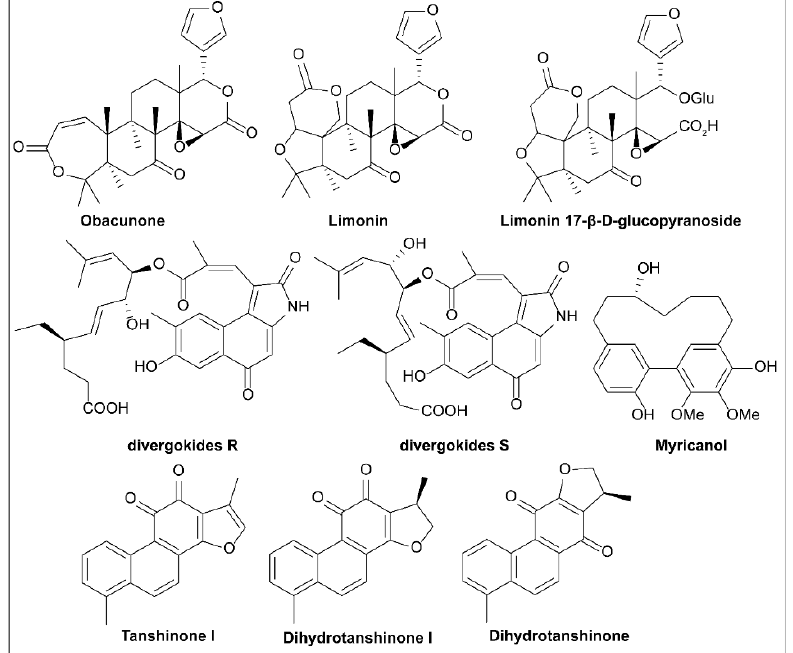
Figure 14. Structures of liminoids, divergokide R and divergokide S, tanshinones, and myricanol.